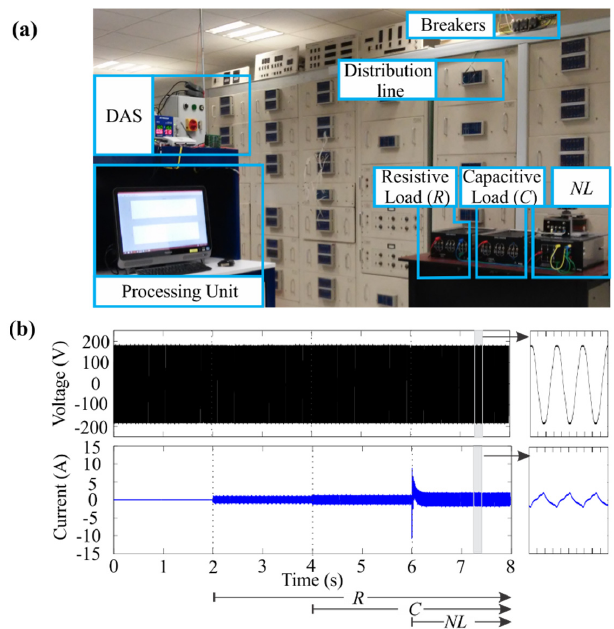
Figure 6. Real measurements: ( a ) experimental setup and ( b ) V ( t ) and I ( t ).